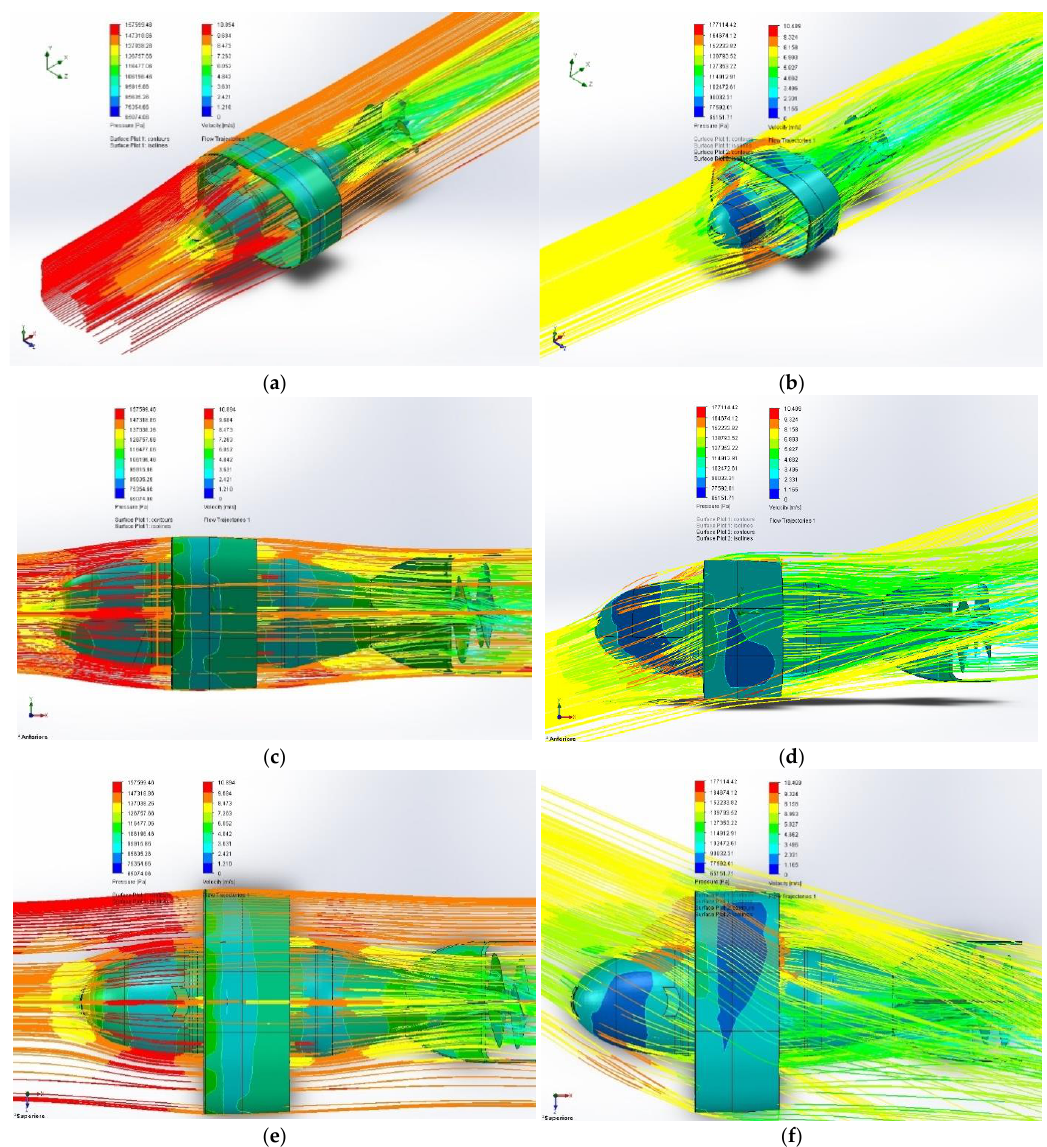
Figure 10. Three views of SolidWorks ® simulation of the drone ( a , c , e ) angle of attack null; ( b , d , f ) angle of attack not null (15° xy plane, 15° xz plane).